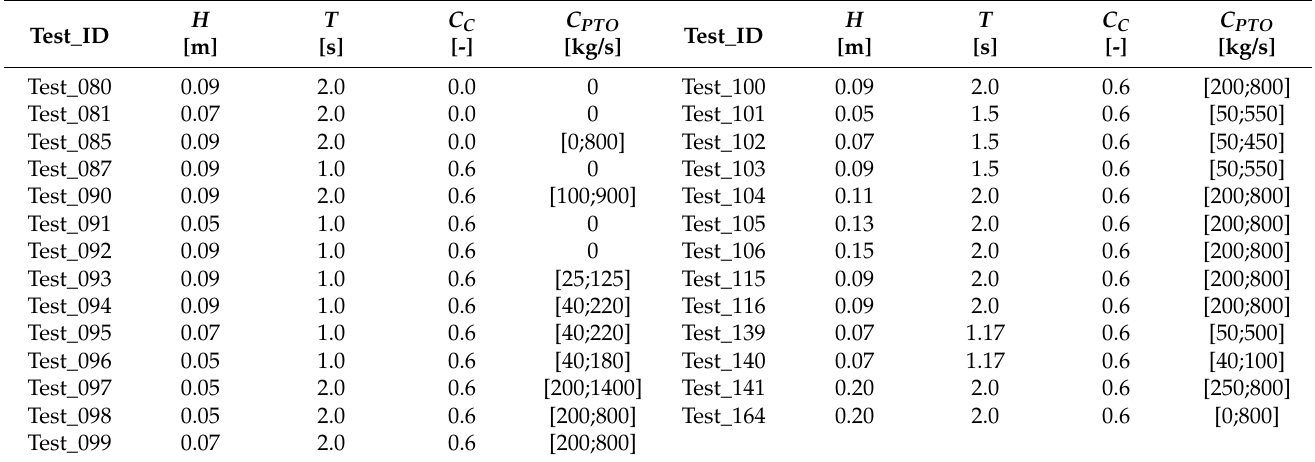
Table 8. Overview of the resistive control strategy tests for regular waves.